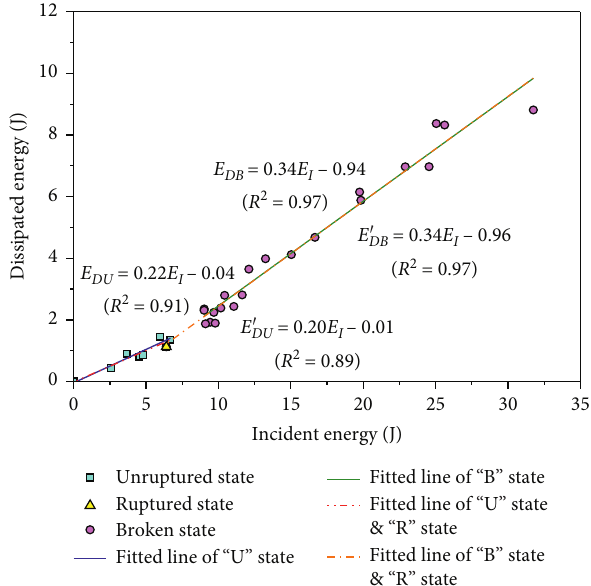
Figure 10: Fitted lines of the incident energy-dissipated energy in the “ U ” state, “ B ” state, “ U ” state ＆ “ R ” state, and “ B ” state & “ R ” state (“ U ” state is the unruptured state, “ B ” state is the broken state, and “ R ” state is the ruptured